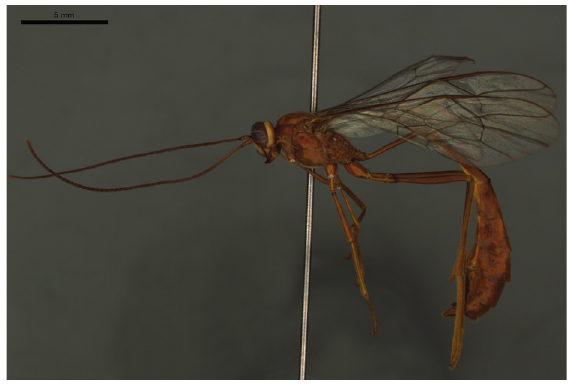
Figure 1 - Aphanistes ruthae Alvarado, 2018, male